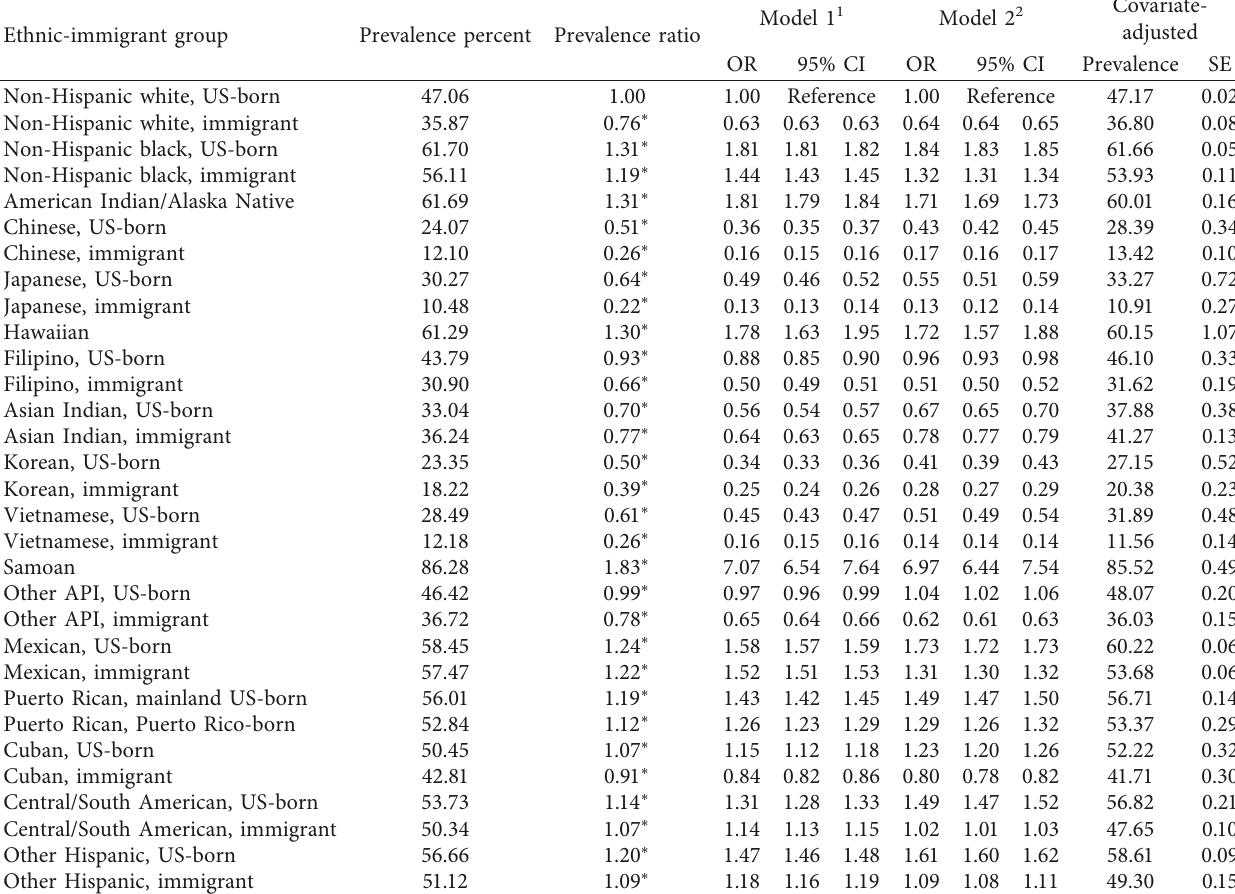
Table 5: Observed prevalence and adjusted odds and prevalence of pre-pregnancy overweight or obesity (BMI ≥ 25) among women in 31 ethnic-immigrant groups, United States, 2012–2014 ( N � 10 , 431 ,